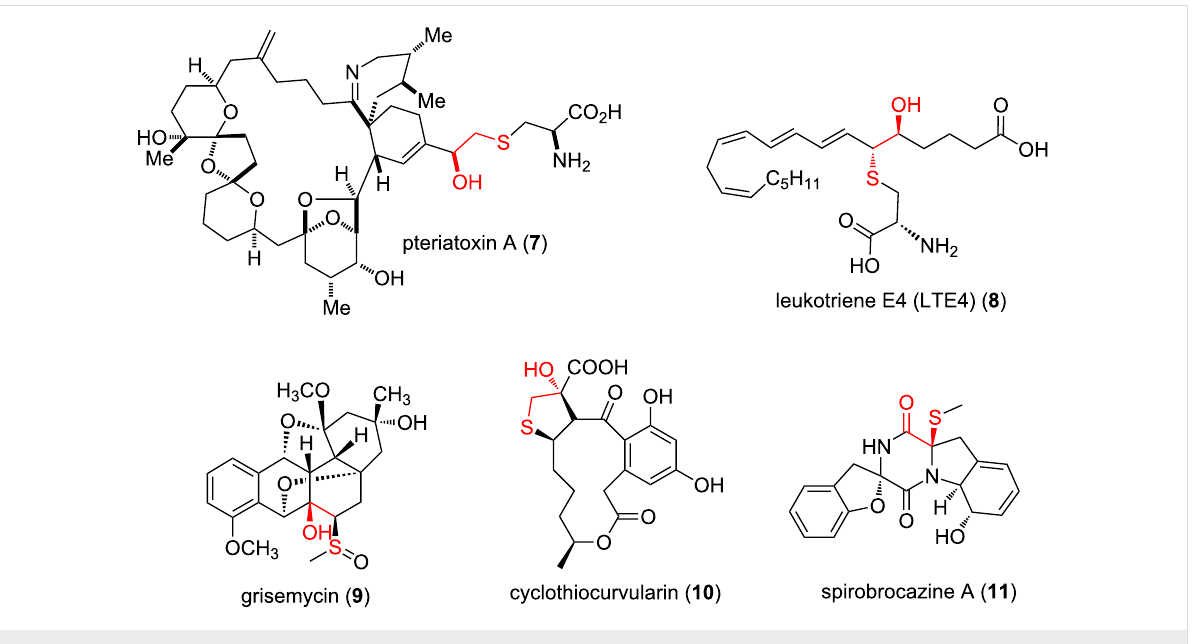
Figure 2: Some natural products incorporating β -hydroxy sulfide moieties.